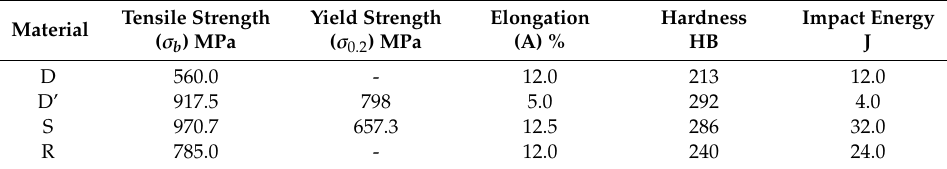
Table 2. Mechanical properties of the testing materials.